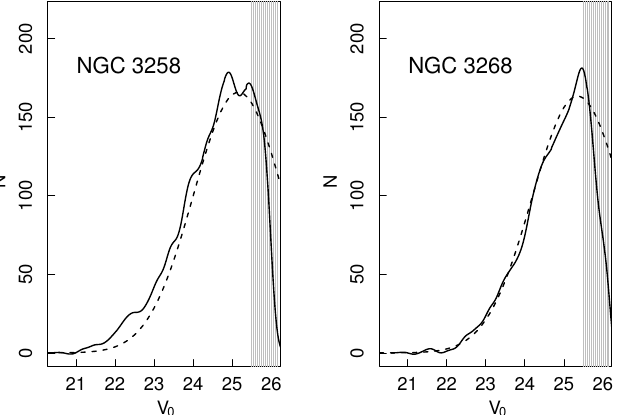
Figure 3. In each panel the smoothed GC luminosity function from FORS1 data is represented with a solid line, while the dashed one represents the Gaussian fitted to the data. The shaded regions indicate the regions with fainter magnitudes than our limit due to the completeness